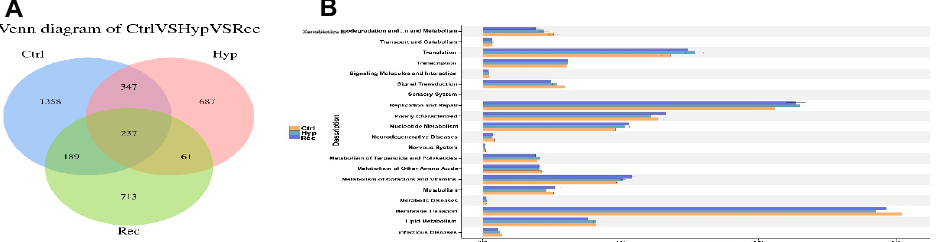
Figure 10. ( A ): Venn diagram showing number of OTUs shared between and among Ctrl, Hyp, and Rec groups ( n = 10). ( B ): Abundance ratio of intestinal microflora in Ctrl, Hyp, and Rec groups with predicted level 2 functions ( n = 10).